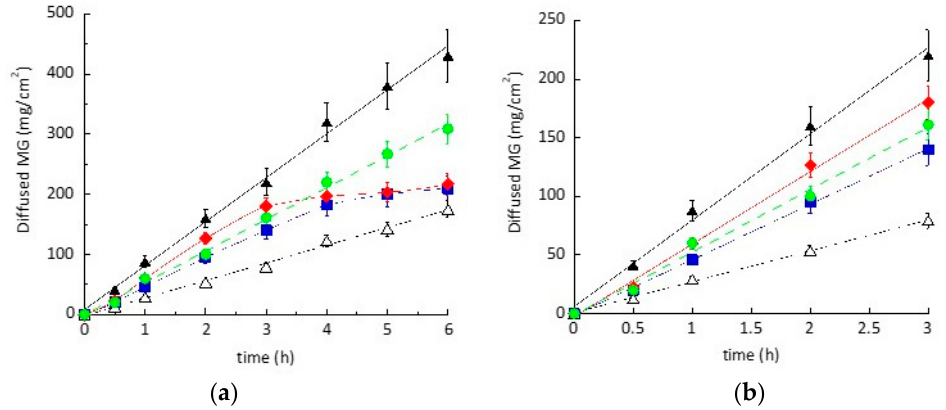
Figure 4. MG diffusion kinetics from Sol-MG (closed triangles), P7-MG (open triangles), P9-MG (green circles), P11-MG (red rhombuses), and P12-MG (blue squares), as determined by Franz cell. Experiments were conducted for 6 h ( a ), with linear profiles within 3 h ( b ). Data are the mean of 6 independent experiments ± s.d.